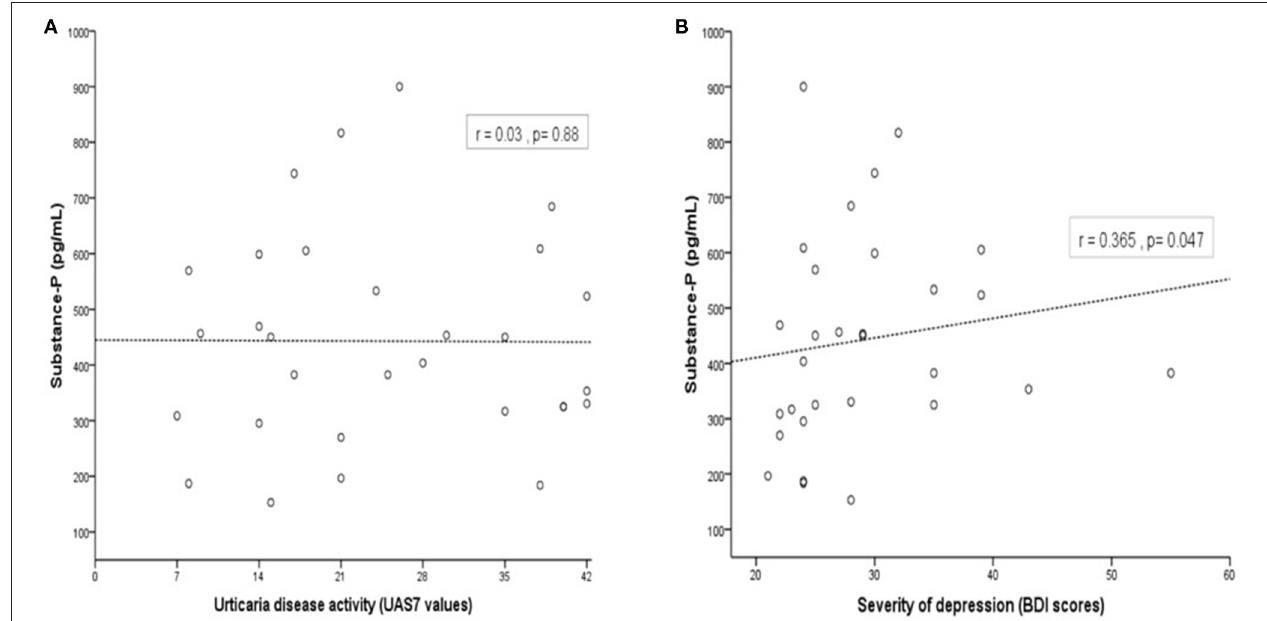
FIGURE 3 | In patients with CSU and depression, SP is correlated with the severity of comorbid depression but not with CSU activity. Concentration of SP serum levels was not correlated with CSU disease activity (measured by UAS7, r = 0.03, p = 0.88; (A) and but correlated with severity of comorbid depression (assessed by BDI, r = 0.365, p = 0.047; (B)